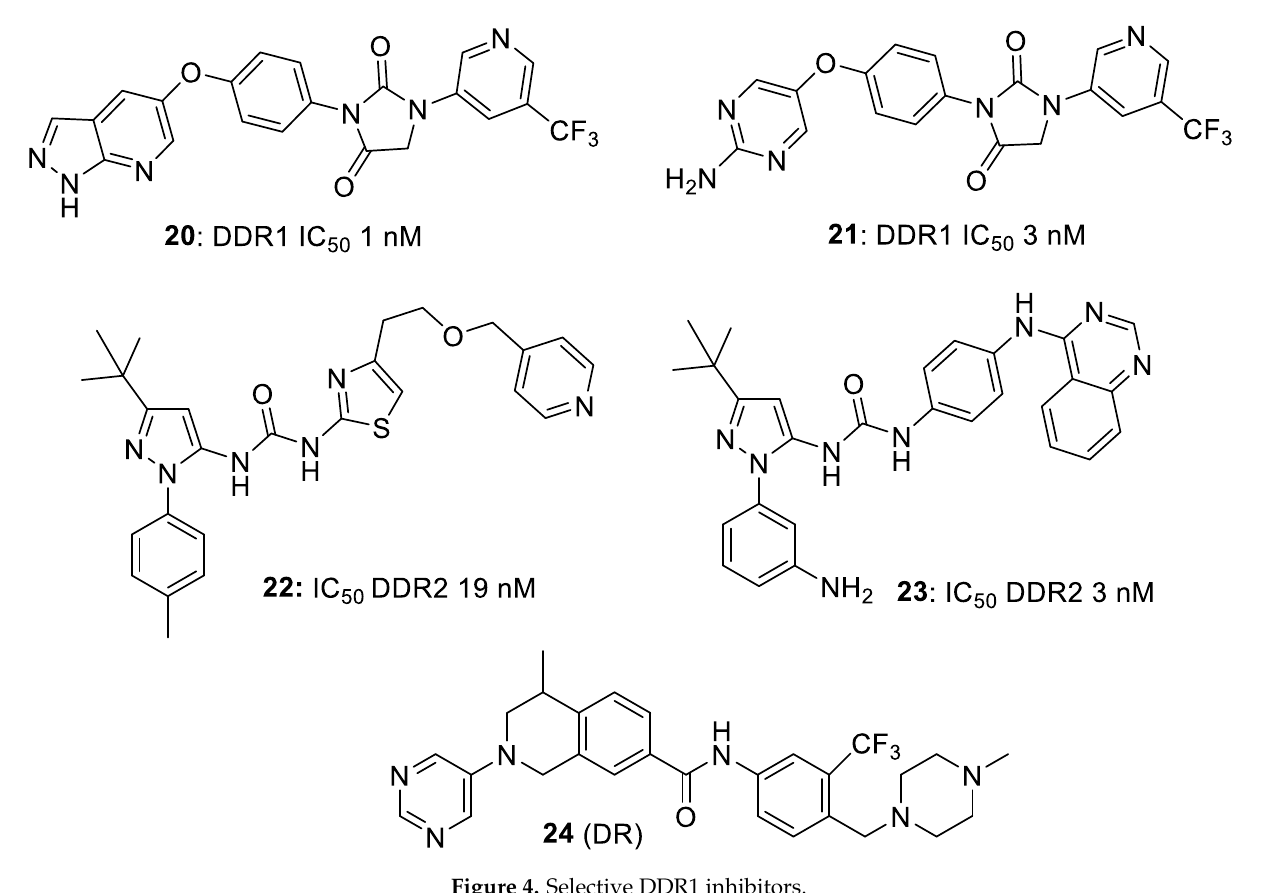
Figure 4. Selective DDR1 inhibitors.